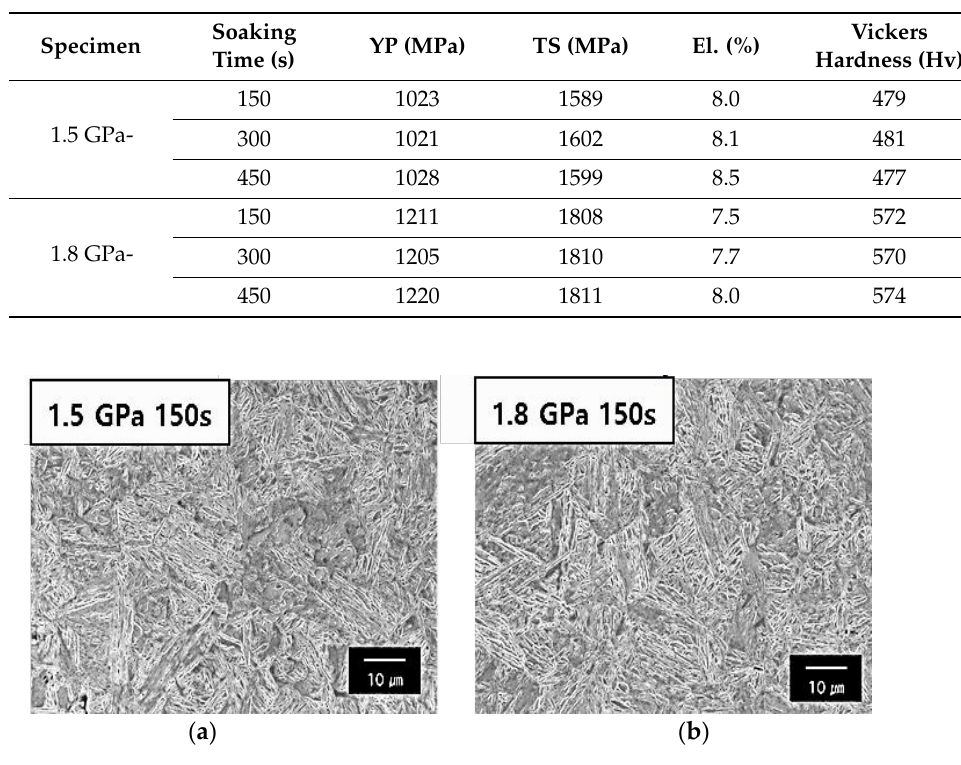
Figure 3. Results of X-ray diffraction of martensitic phase on the 1.5 GPa and 1.8 GPa grade steels austenitized for 150 s at 1203 K; The indication of α/ α’ means ferrite/ martensite with body centered (bcc) structure Figure 4 displays the chemical composition of the coating layer for each steel type corresponding to the holding time in the furnace at 1203 K. During the initial heating stage